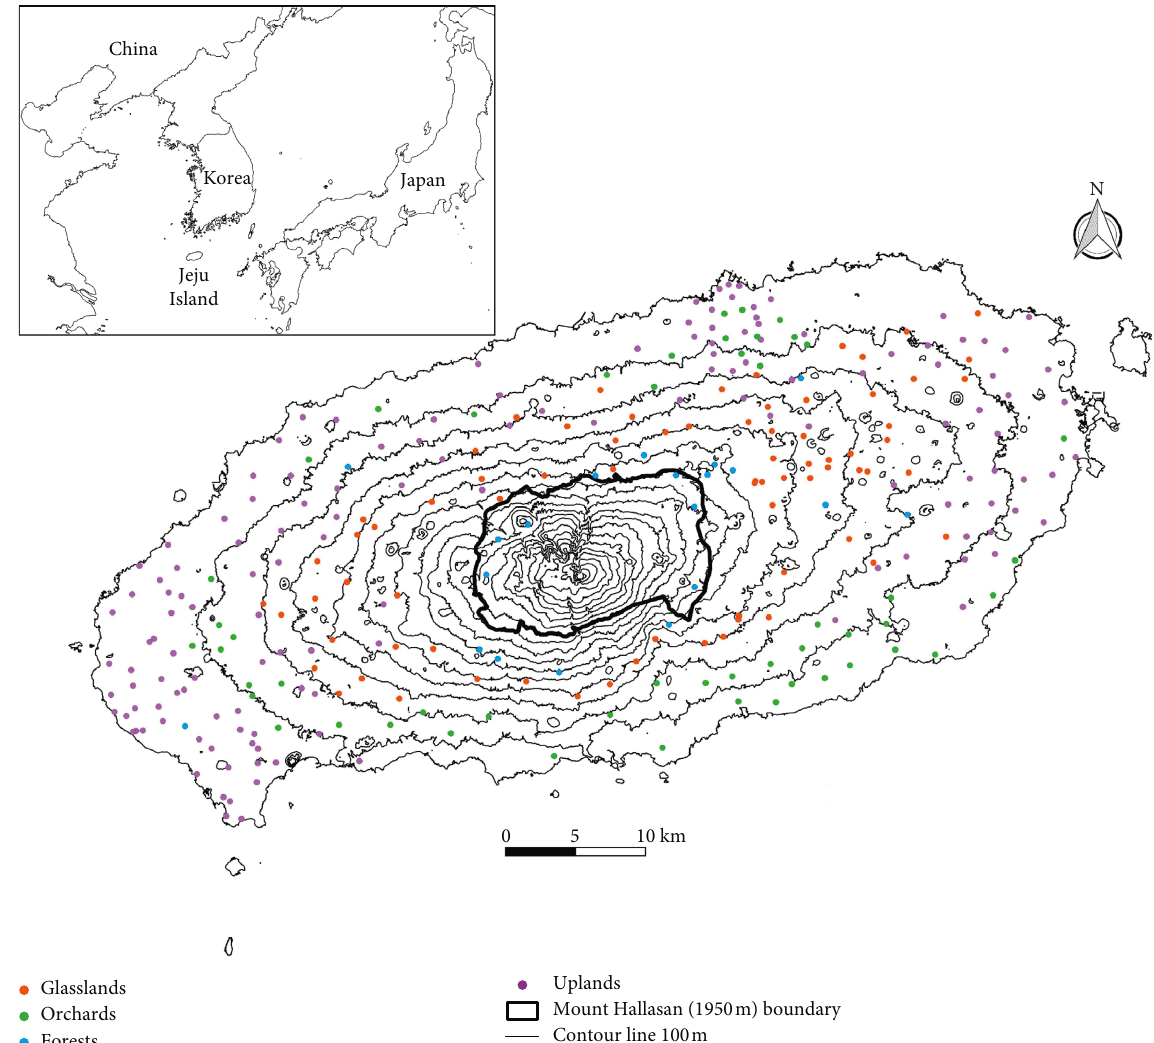
Figure 1: Soil sampling locations on Jeju